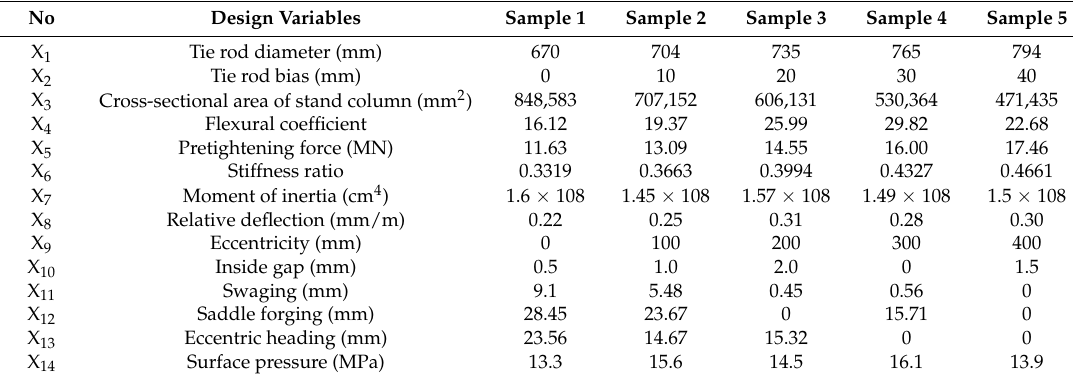
Table 1. The detailed description of design variables.